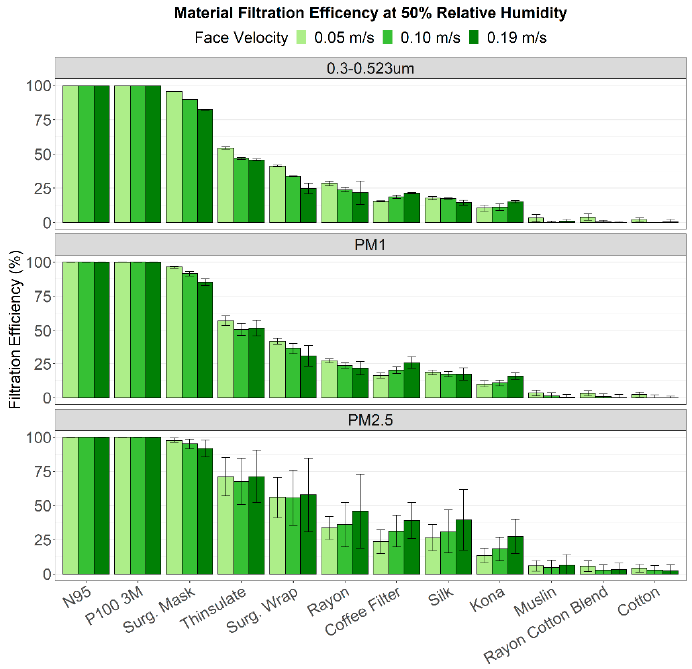
Figure 5. FE results for single-layered materials as a function of face velocity. Bar colors represent the corresponding face velocity values, with the results plotted at the average FE from three experimental runs with the error bars representing the standard deviation.